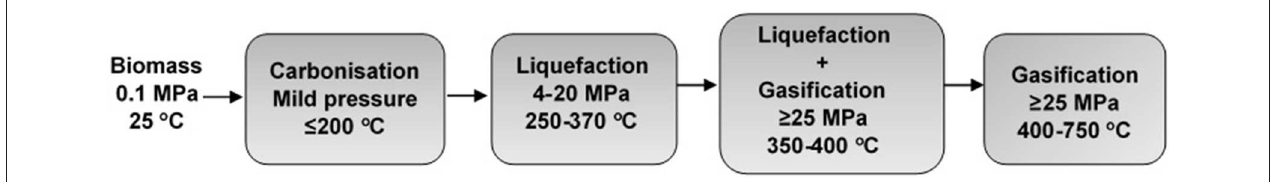
FIGURE 1 | Biomass hydrothermal conversion in a typical process